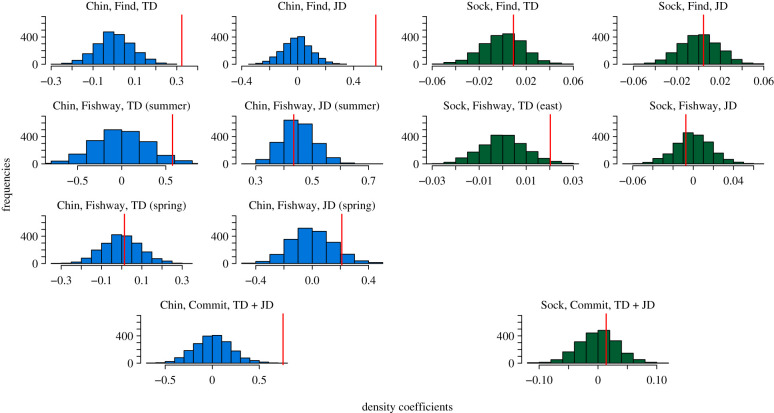
The results of our null distribution simulations. Histograms represent fitted density coefficients from over 2000 simulations of the best fitting null model (with no density effect). Vertical lines represent the density coefficient fitted to our actual data. Chin refers to models of Chinook salmon; Sock refers to models of sockeye salmon. Find, Fishway and Commit refer to our three different process models (figure 1). TD and JD refer to The Dalles and John Day Dams. summer and spring refer to models in which summer-run and spring-run Chinook were separated. East refers to the east fishway at The Dalles Dam. Separation of models beyond species and process were the result of model diagnostic procedures. (Online version in colour.)